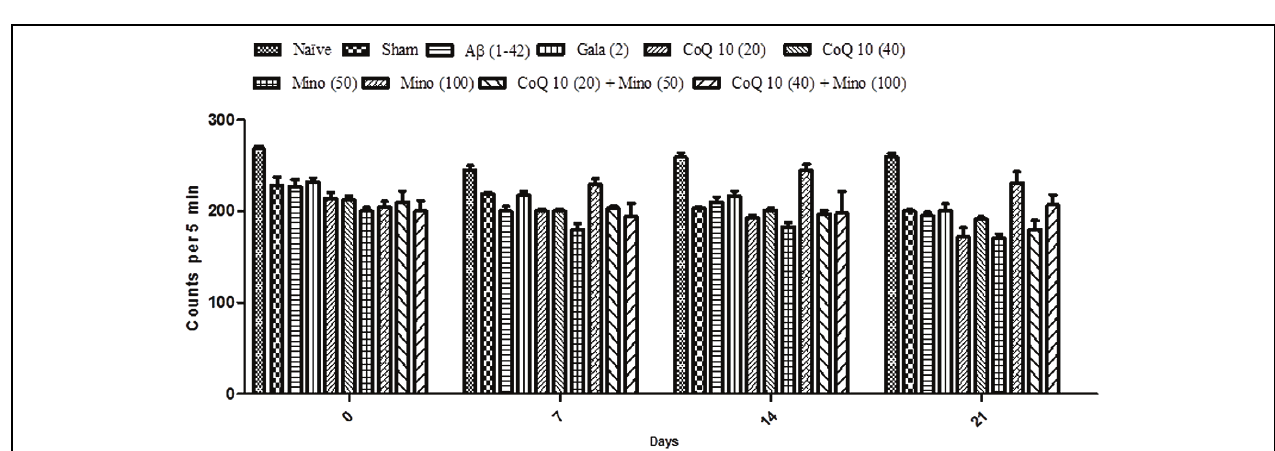
FIGURE 3 | Effect of CoQ10 and minocycline alone and in combination on locomotor activity (ambulation) in A β (1-42) treated rats. Data expressed as mean ± SEM (Two way ANOVA followed by Bonferroni’s test). (A β (1-42), Amyloid beta; Gala, Galantamine; CoQ10, Coenzyme Q 10; Mino, Minocycline).